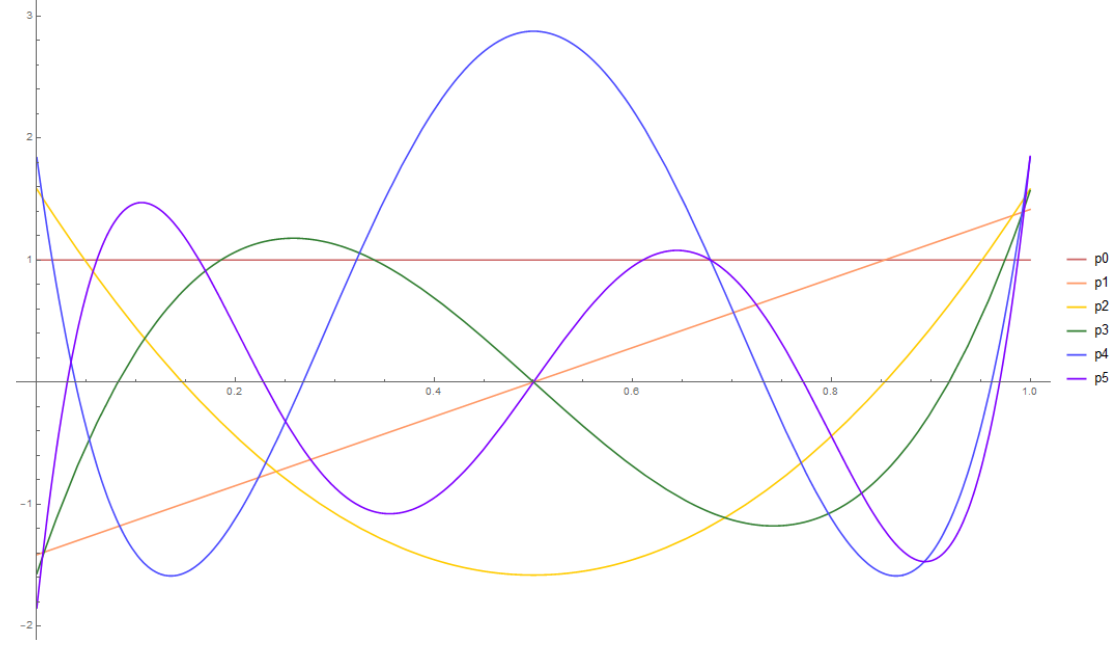
Figure 2: Selected normalized Legendre polynomials for the ternary Cantor